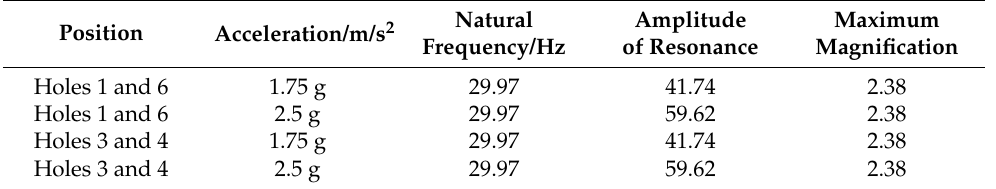
Table 2. Frequency-response results.